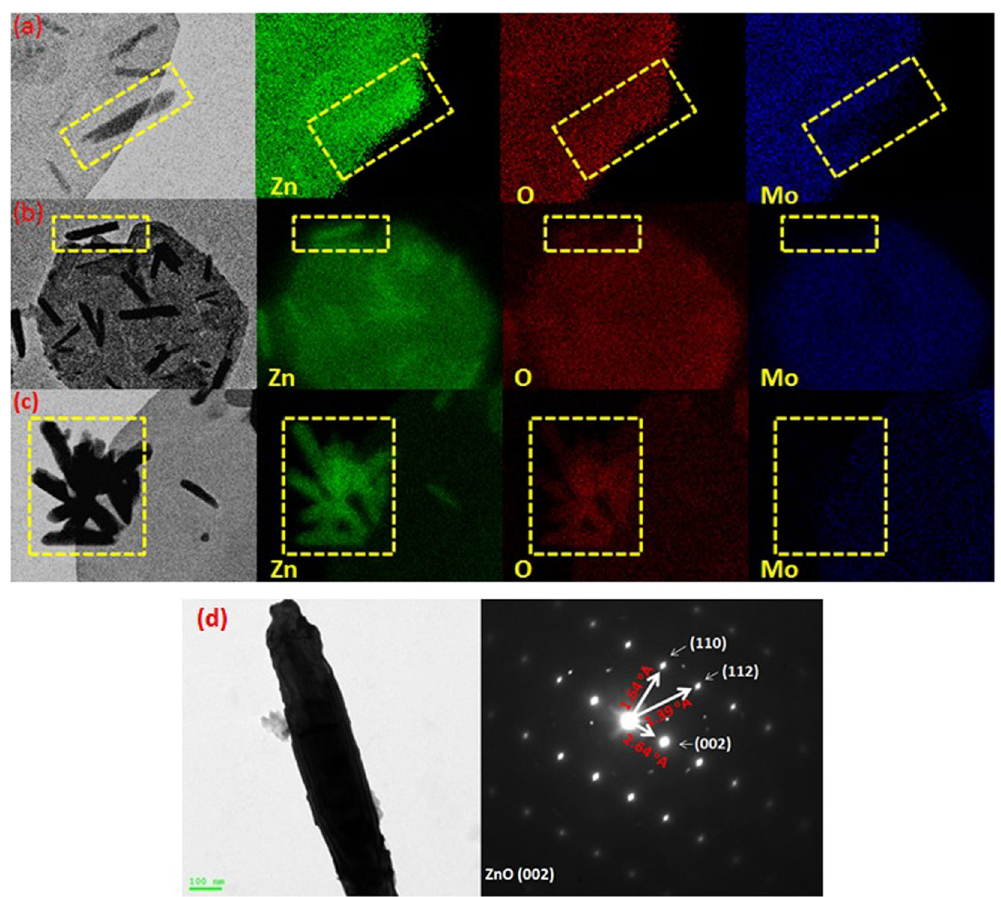
Figure 18. EDX mapping of sample picked up at ( a ) 3.5 minutes, ( b ) and ( c ) 15 minutes after starting of the reaction, and ( d ) HRTEM image of selected ZnO nanorod (left) & its diffraction pattern (right).